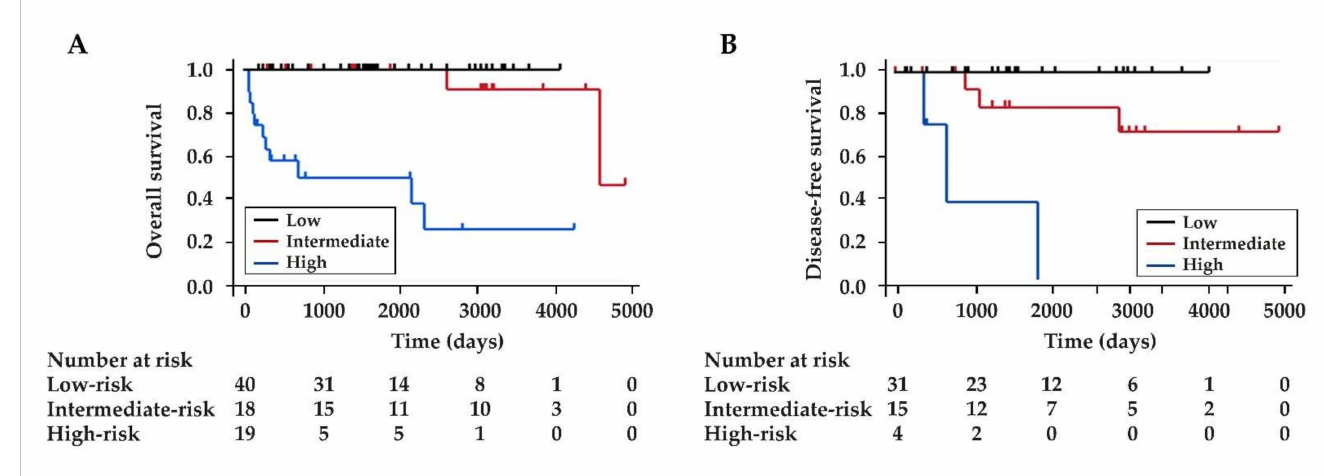
Figure 2. Kaplan–Meier survival curves of overall and disease-free survival stratified by risk groups. ( A ) Overall survival of all enrolled patients and ( B ) disease-free survival of the patients who under- went R0 resection were different between the three groups (both for p < 0.001).